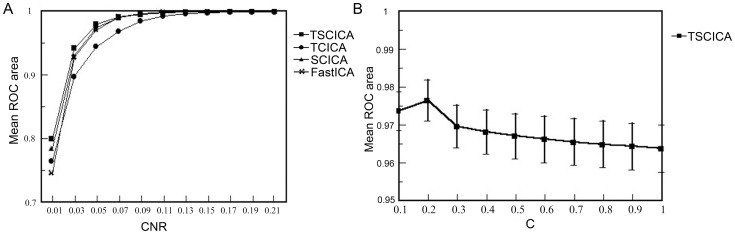
Results of the robustness to noises and determining the penalty parameters.(A) The variation of the mean ROC area with CNR for TSCICA, TCICA, SCICA and FastICA. (B) The variation of the mean ROC area with C of the temporal penalty parameter γ2. The error bar represents the standard error of the mean.